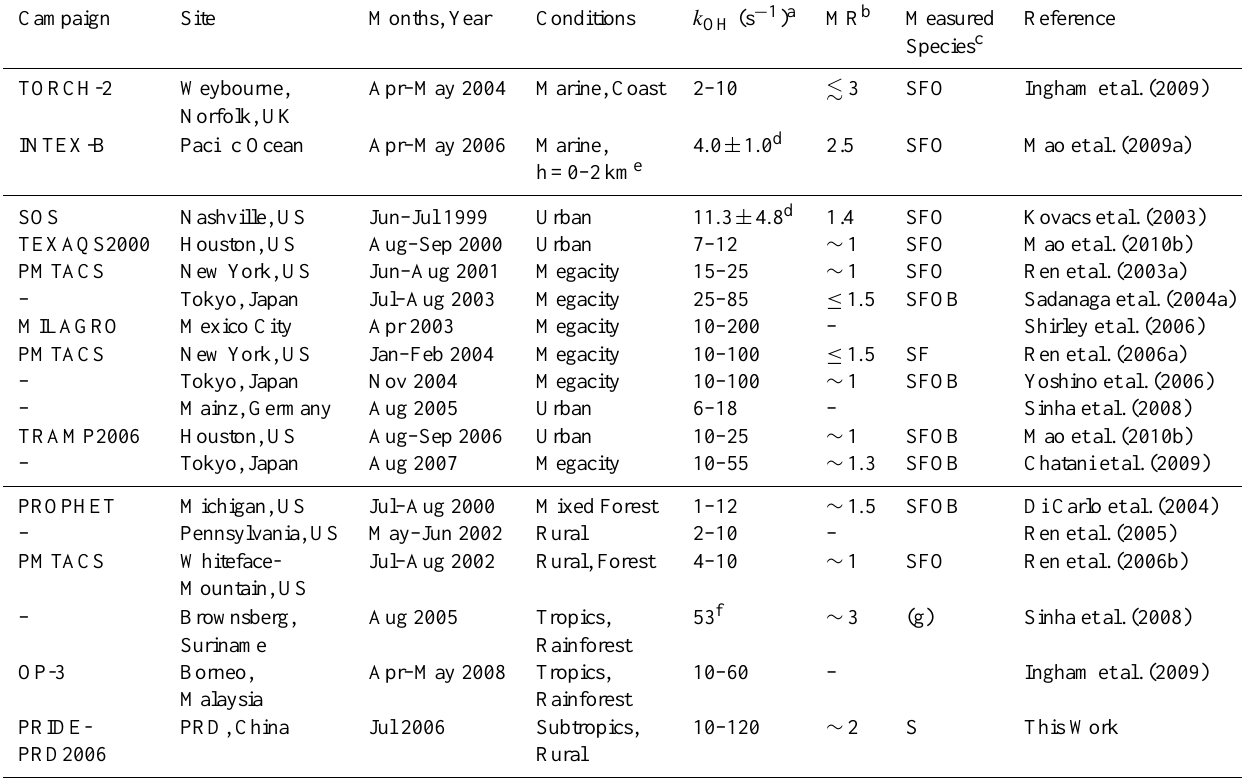
Table 1. OH reactivities measured in the atmospheric boundary